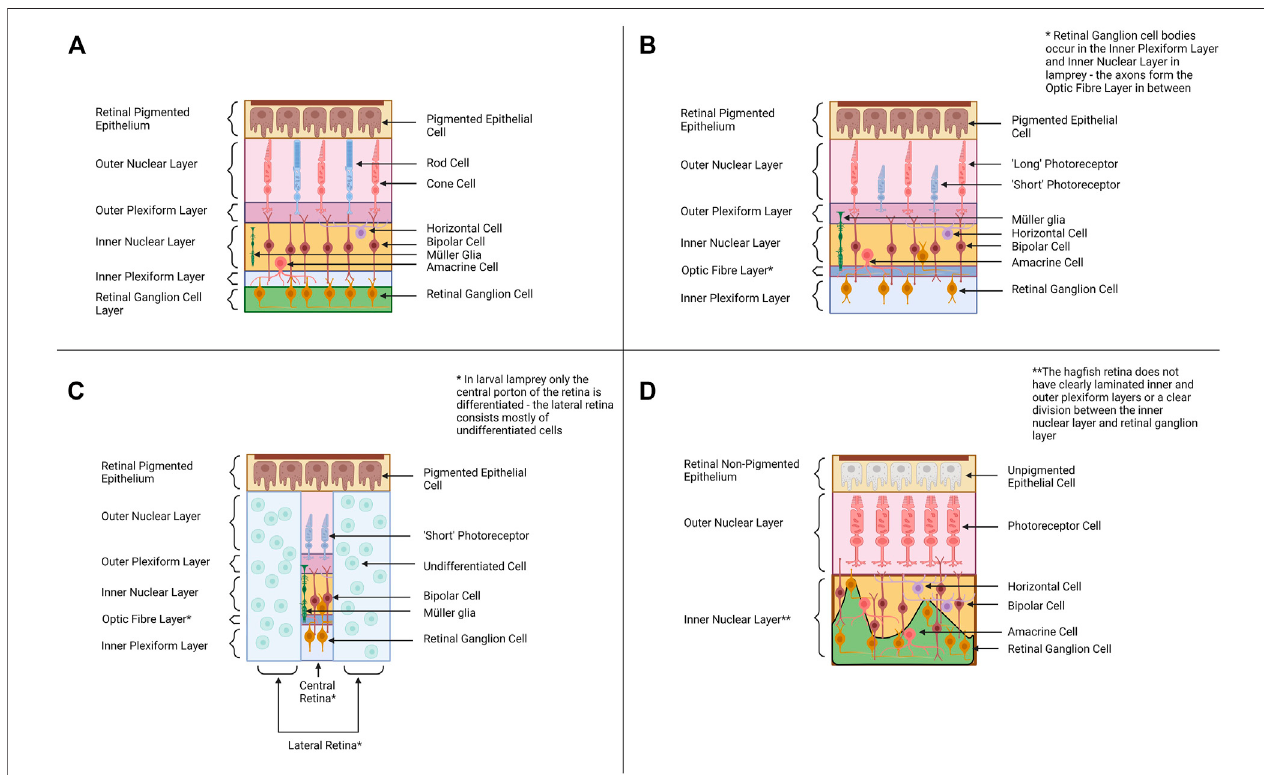
FIGURE 2 | Retinal Organization across Cyclostomes and Gnathostomes provides a backdrop for alternative hypotheses of vertebrate eye evolution. (A) Across most allgnathostomes,theretinaiscomposed offour distinct cellular layers — theretinal pigmented epithelium, theouternuclear layer(ONL)containingphotoreceptors, the inner nuclearlayer (INL)containingbipolar cellsand otherinterneuronsand theretinal ganglioncelllayer(RGC) containingretinal ganglioncells. (B) Theadult lamprey retina has a similar organization to the gnathostome retinal plan. The photoreceptors have a distinct morphology and the retinal ganglion cell bodies occur in the innernuclearlayerandtheinnerplexiformlayerratherthanformingtheirowndistinctcellularlayer. (C) Thepre-metamorphiclarvallampreyretinaisdistinctfromtheadult as it has only a small differentiated central retina (contains one type of photoreceptor, bipolar cells, retinal ganglion cells and Müller glia) and a larger undifferentiated peripheralretina.Retinaldifferentiationandtheformationofhorizontalandamacrinecellsoccursduringmetamorphosis. (D) Thehag fi shretinaismorphologicallydistinct from lamprey and gnathostome retinae, and this is intriguing when considering its position in the phylogeny ( Figure 1A ). The retinal epithelium is unpigmented, and the lamination between the presumptive inner nuclear layer and the retinal ganglion cell layers is poor. Despite the reduced organization, molecular studies support the hag fi sh retina contains all four cellular layers seen in lamprey and gnathostomes (Dong and Allison, 2021). Graphics created using BioRender.com.